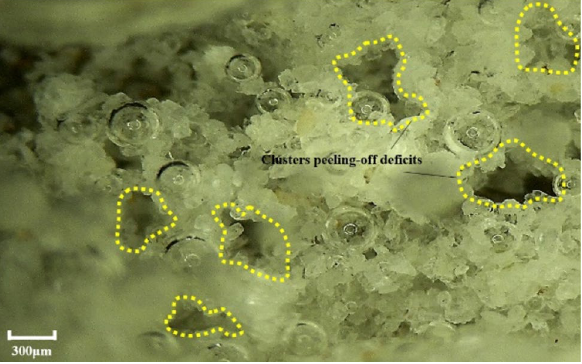
Fig. 19 Microscopic view of weakly-cemented interface detachment deficits in the middle of the No.8 sample